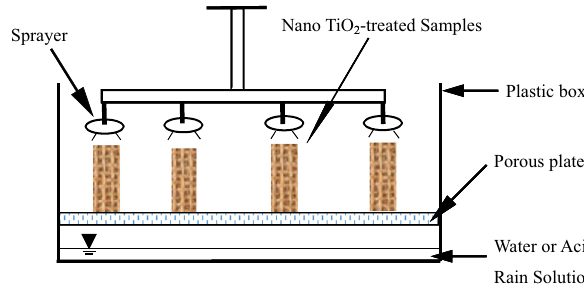
Figure 2: Acid - resistant rectangular tank.